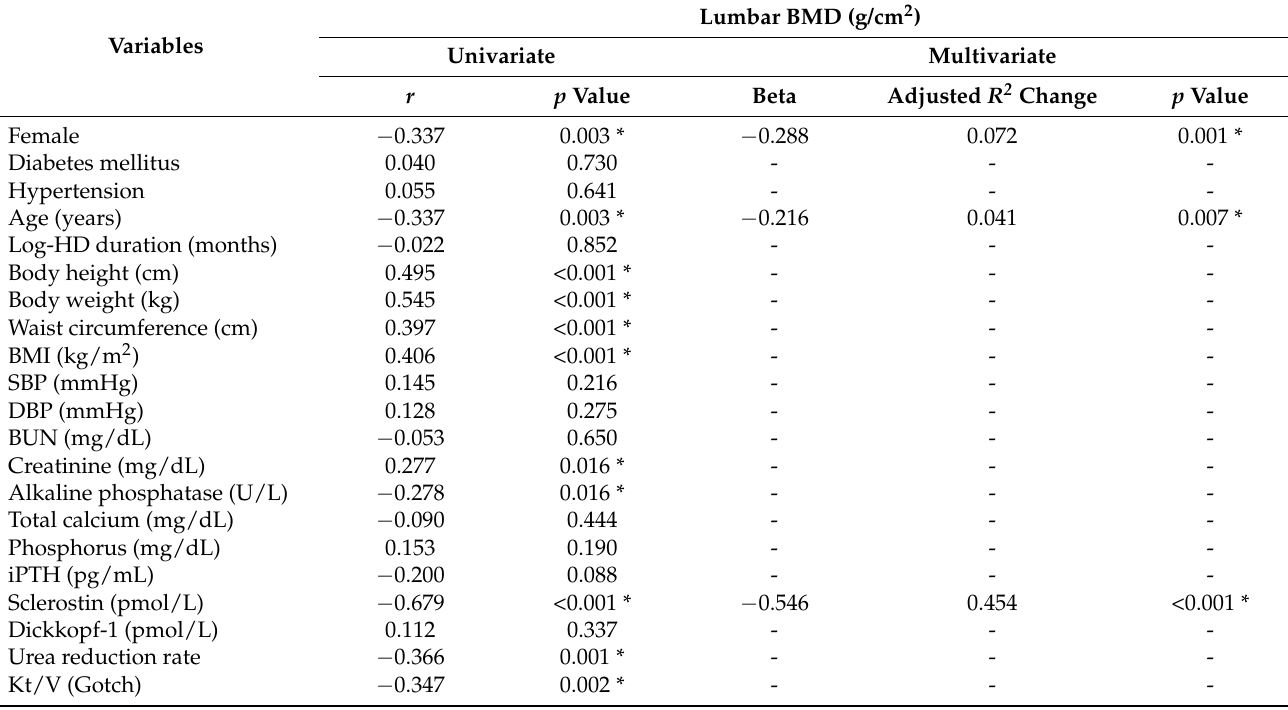
Table 3. Correlation of lumbar bone mineral density levels and clinical